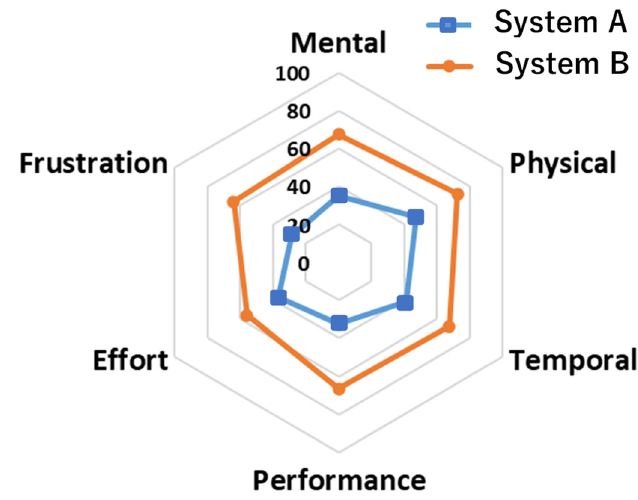
Figure 23. Questionnaire results with NASA-TLX.